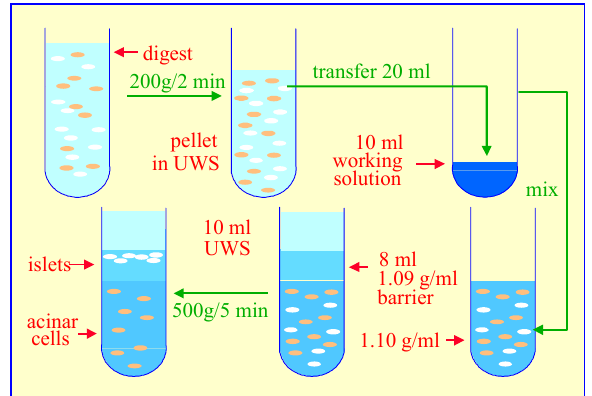
FIGURE 1. Islet purification flow